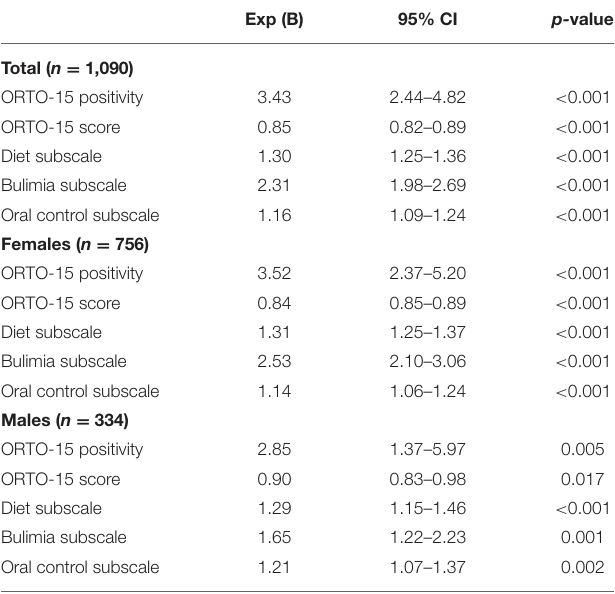
TABLE 5 | Logistic regressions analysis for the presence of ED risk, stratified by sex controlled for sport type. Exp